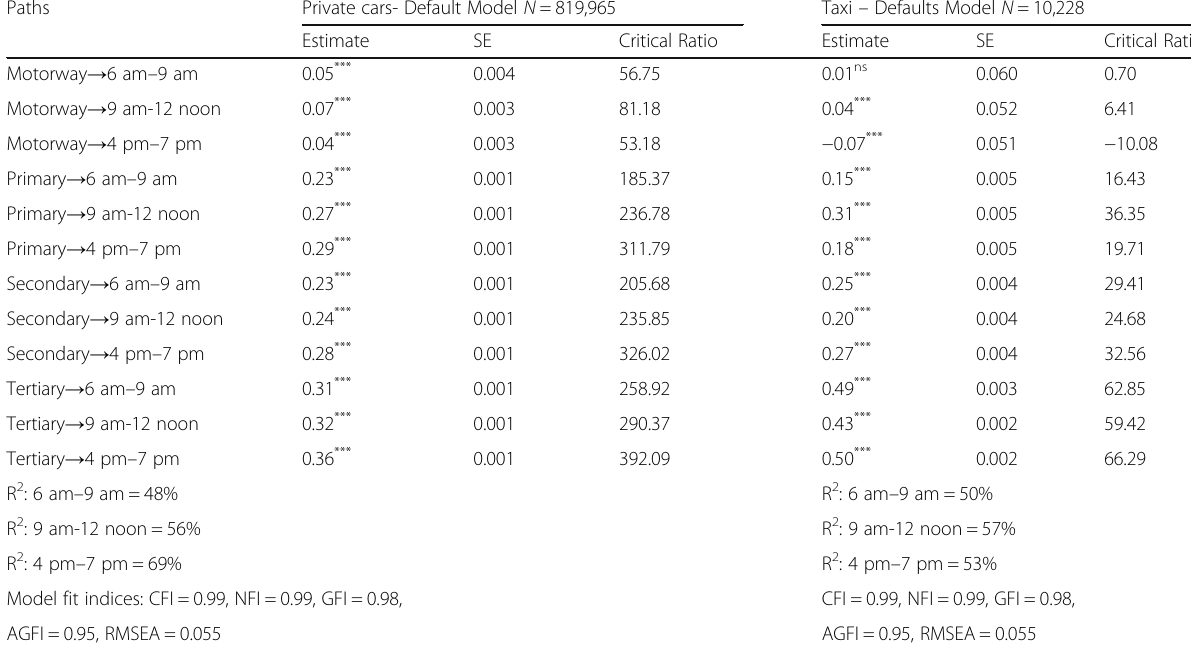
Table 9 Structural Model: Comparing road choice of private car and taxi predicting peak hours Paths Private cars- Default Model N =